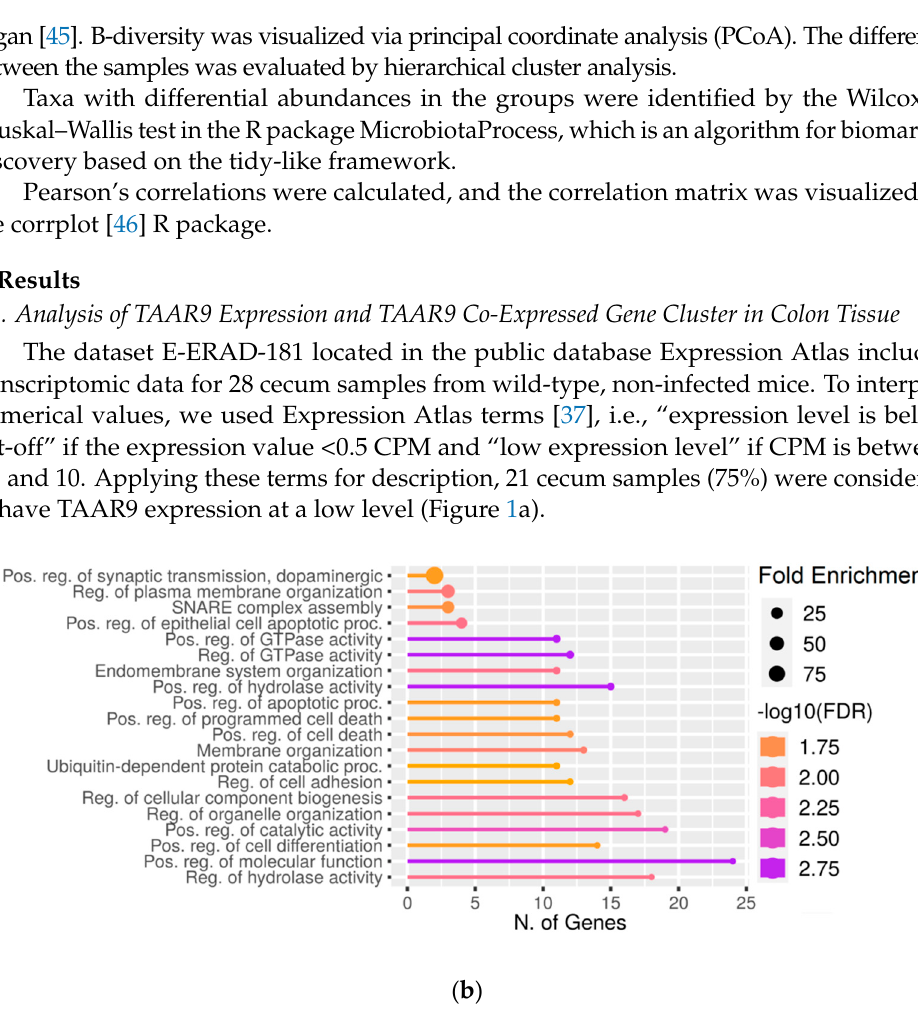
Figure 1. TAAR9 expression in mouse cecum. ( a ) TAAR9 mRNA expression in non-treated C57BL/6 mice (dataset E-ERAD-181); ( b ) gene ontology enrichment analysis of top 100 TAAR9 co-expressed genes. CPM—count per million, FDR—false discovery rate.